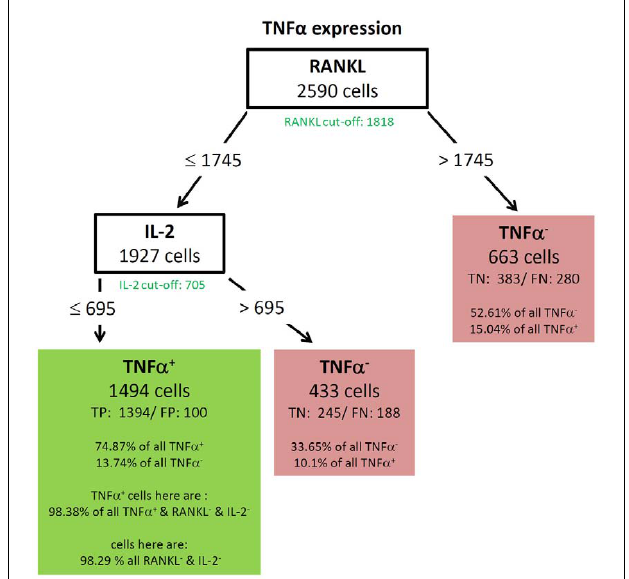
FIGURE 5 | Best decision tree for the classification of cells as positive or negative forTNF- α expression. Cells are classified based on the MFI values of first RANKL and second IL-2.The green colored cut-off values below the inner nodes, indicate that the split values are close to the cut-off values.Therefore, these nodes dived the cells in RANKL (respectively IL-2) negative and positive cells.The cells are routed to the right leaf if they do not express RANKL. Cells of this leaf are classified as negative and this leaf capture 52.61% of allTNF- α negative cells, and only classifies 15.04% of theTNF- α positive cells incorrectly.The leaf in the middle classifies cells as TNF- α negative which do not express RANKL, but do express IL-2.The left node classifies cells asTNF- α positive and captures 74.87% of theTNF- α positive cells.This node contains not all RANKL and IL-2 negative cells, but 98.38% of them. Since the split values of RANKL and IL-2 are slightly below the real cut-off a few RANKL and IL-2 positive cells have been routed to the right and are therefore not contained in the leftmost leaf.